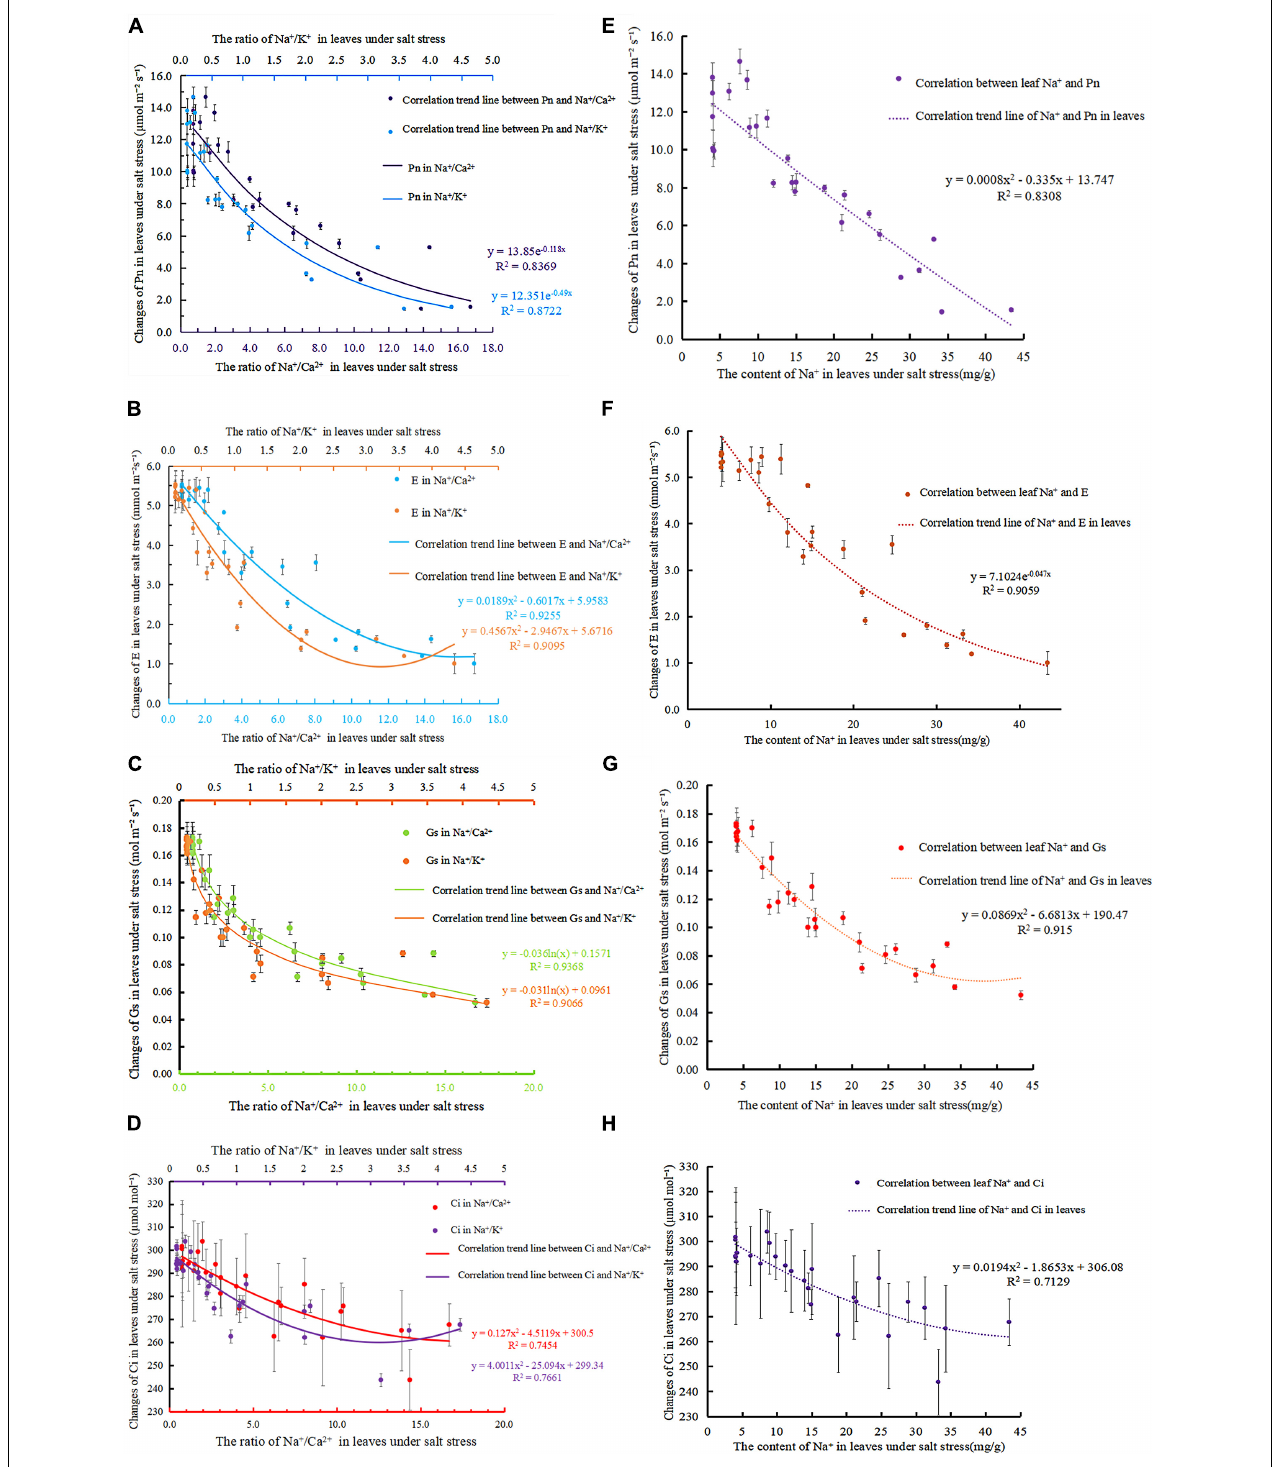
FIGURE 4 | Correlation between photosynthetic gas parameters and ions in leaves under salt stress; (A) correlation of Na + / Ca 2 + and Na + / K + in the leaves of S. matsudana to Pn under salt stress; (B) correlation of Na + / Ca 2 + and Na + / K + in the leaves of S. matsudana to E under salt stress; (C) analysis of the correlation of Na + /Ca 2 + and Na + /K + in the leaves of S. matsudana with Gs under salt stress; (D) correlation of Na + /Ca 2 + and Na + / K + in the leaves of S. matsudana to Ci under salt stress; (E) correlation of Na + and Pn in the leaves of S. matsudana under salt stress; (F) correlation of Na + in the leaves of S. matsudana to E under salt stress; (G) correlation of Na + in the leaves of S. matsudana with Gs under salt stress; (H) correlation of Na + in the leaves of S. matsudana with Ci under salt stress.